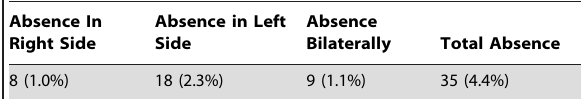
Table showing the overall absence of the Palmaris longus muscle in the study.